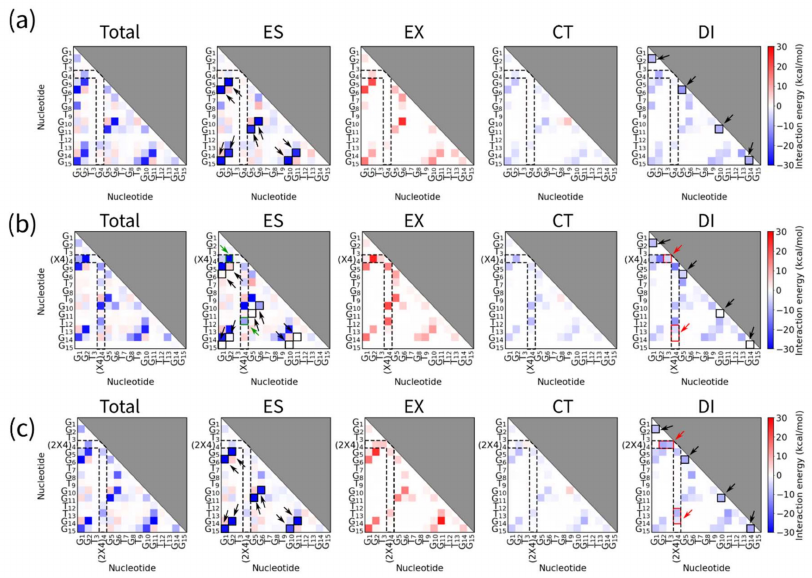
Figure 5. Total electrostatic (ES), exchange repulsion (EX), charge transfer (CT), and dispersion force (DI) energy graphs are shown, indicating the interaction energies between each base in ( a ) Q1, ( b ) Q1-(X4) 4 , and ( c ) Q1-(2X4) 4 . Interactions of T 4 , (X4) 4 , or (2X4) 4 with other bases were highlighted by broken lines. Blue squares with black arrows in ES and DI indicate hydrogen bonds and stacking interactions in G-quartets, respectively. Blue squares with green arrows in ES and with red arrows in DI show hydrogen bonds and CH- π interactions of (X4) and (2X4) with bases of G-quadruplexes,